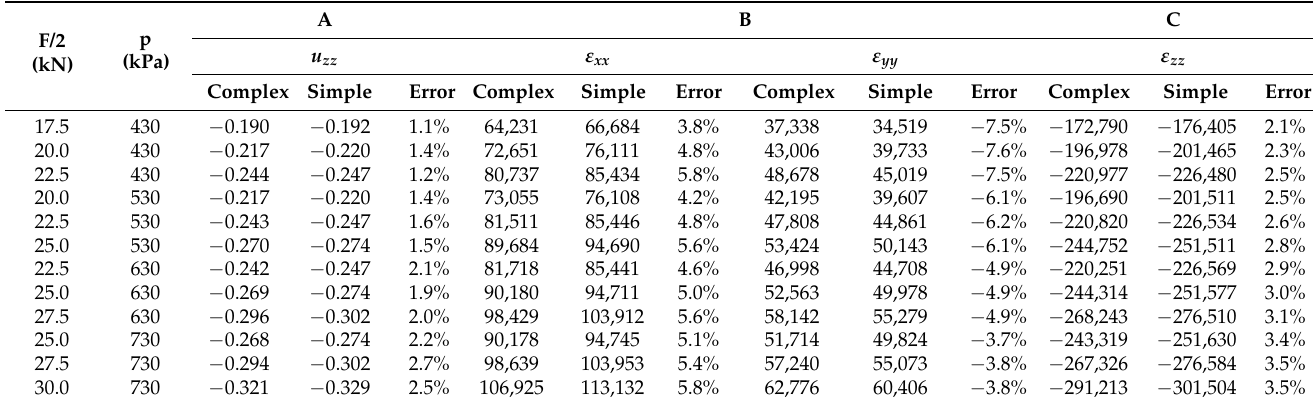
Table 9. Stresses and strains in the flexible road pavement structure between two tyres of the twin tyre.